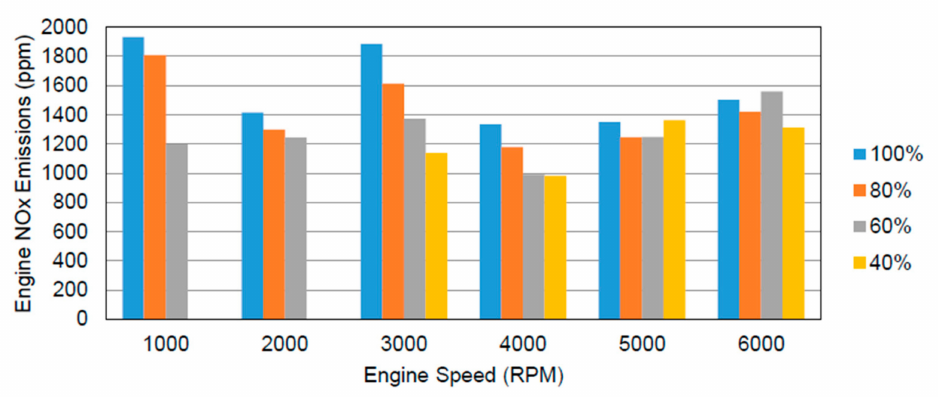
Figure 20. Baseline engine carbon monoxide emissions at di ff erent engine loads.